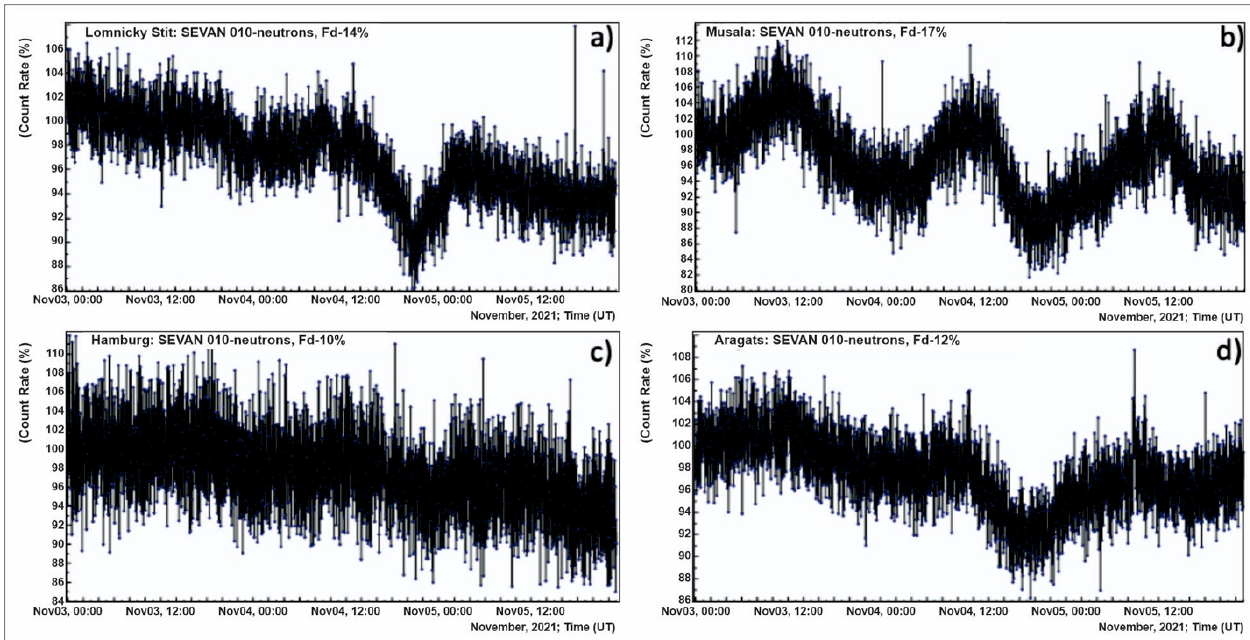
Figure 17. 1 min time series of count rates of “010” coincidence of SEVAN layers (primarily neutrons) for 4 nodes in Slovakia ( a ), Bulgaria ( b ), Germany ( c ), and Armenia ( d ).